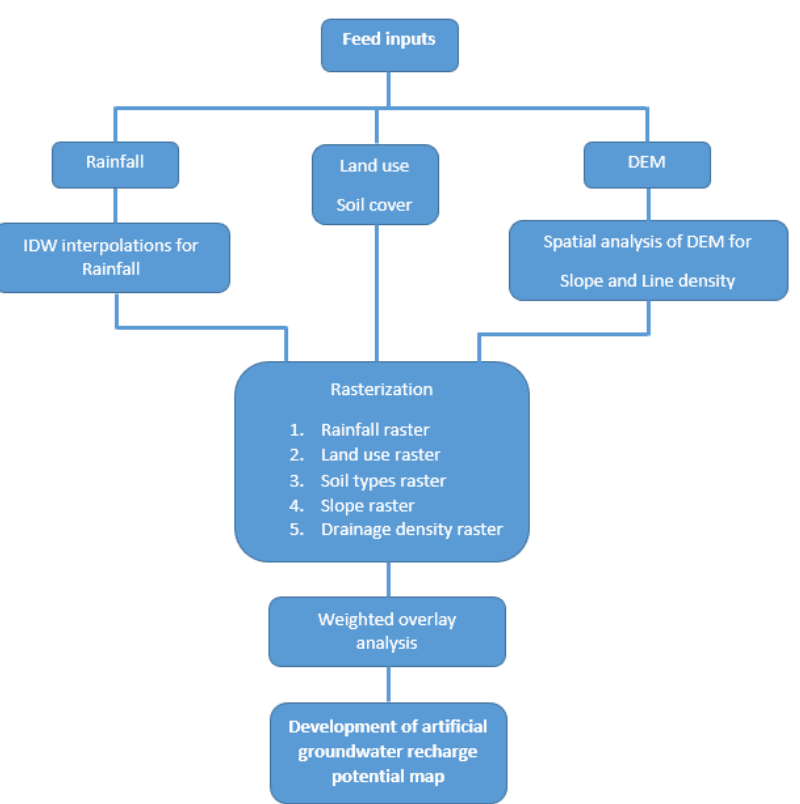
Figure 4. Overview of the research methodology adopted in the current study.